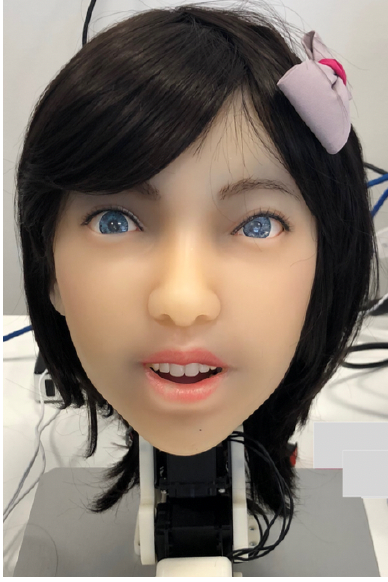
Figure 2: The EveR-4 (“EveR”) robot smiles.